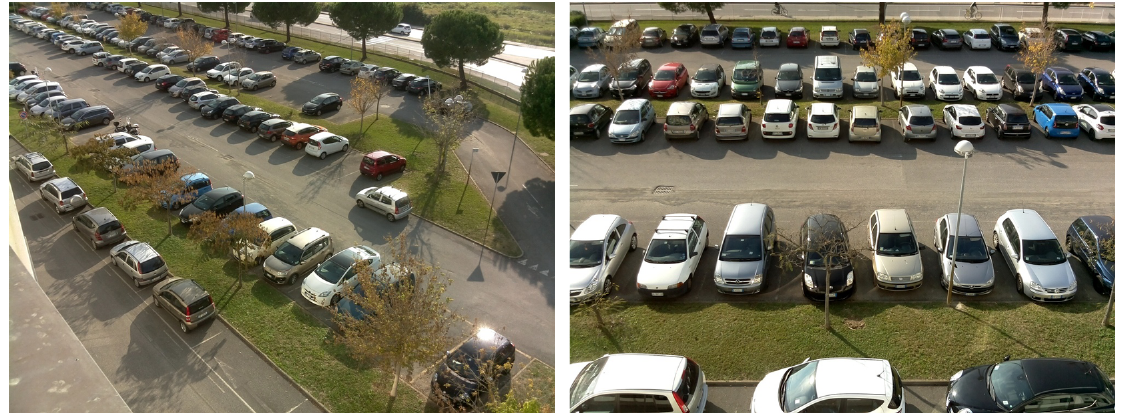
Figure 4. Example photos from CNRPark + EXT dataset [5].